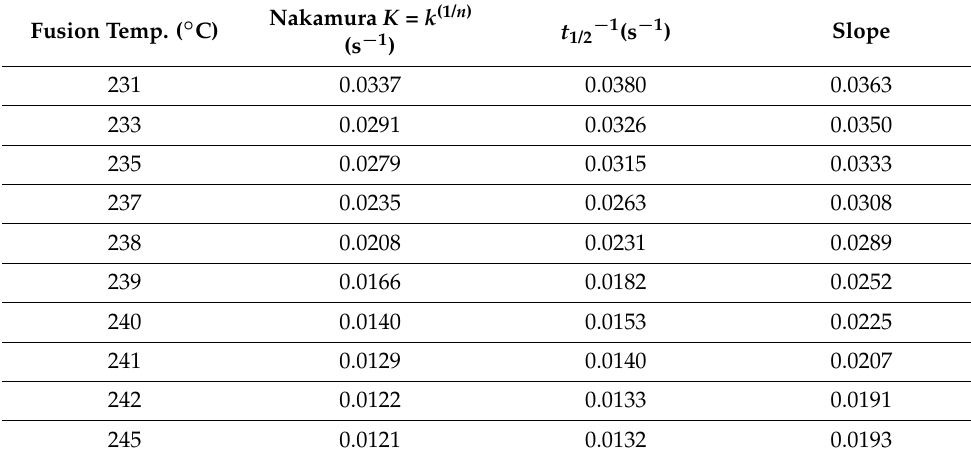
Table 3. Kinetics parameters at different fusion temperatures.